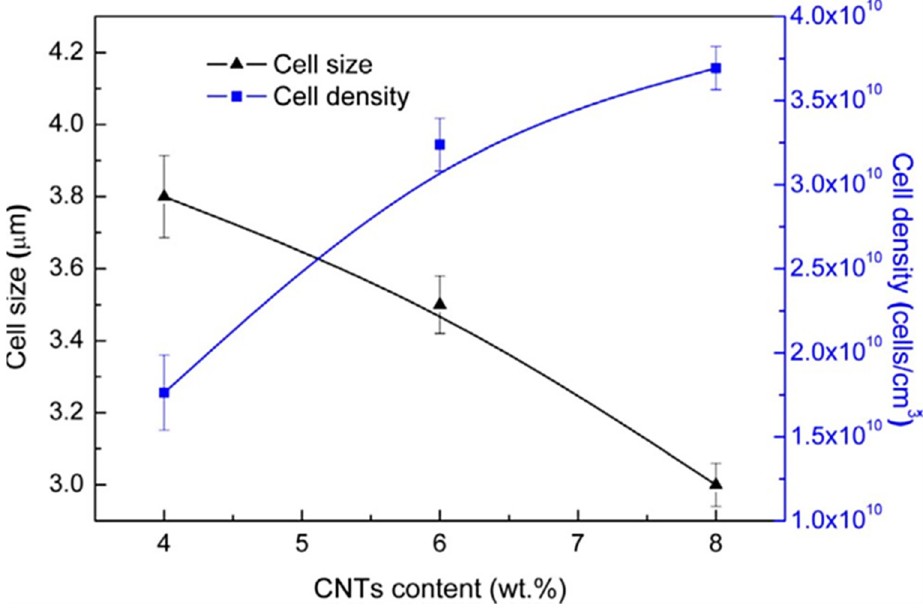
Figure 5. Cell size and cell density of PMMA/CNT nanocomposite foam [53]. PMMA/CNT = poly(methyl methacrylate)/carbon nanotube. Reproduced with permission from Elsevier.